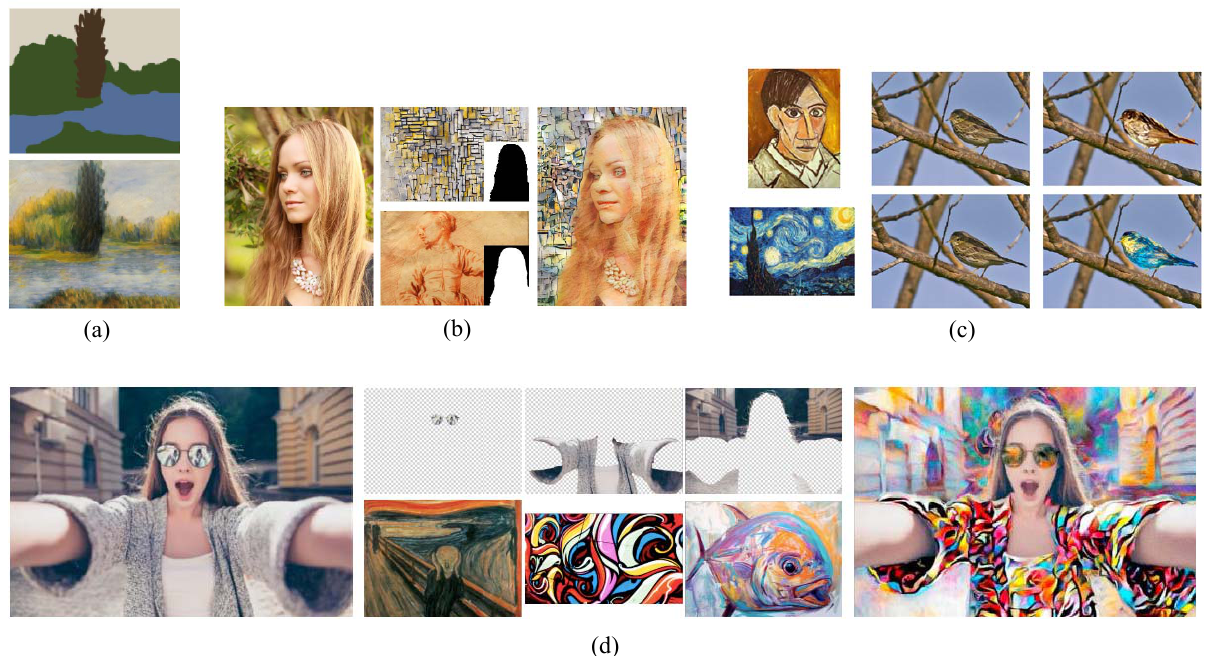
Figure 14. The similar results from existing works: ( a ) doodle-based style transfer [9], ( b ) style transfer on bi-segmented image [10], ( c ) stylization on segmented region [12], ( d ) universal style transfer on multi-segmented image